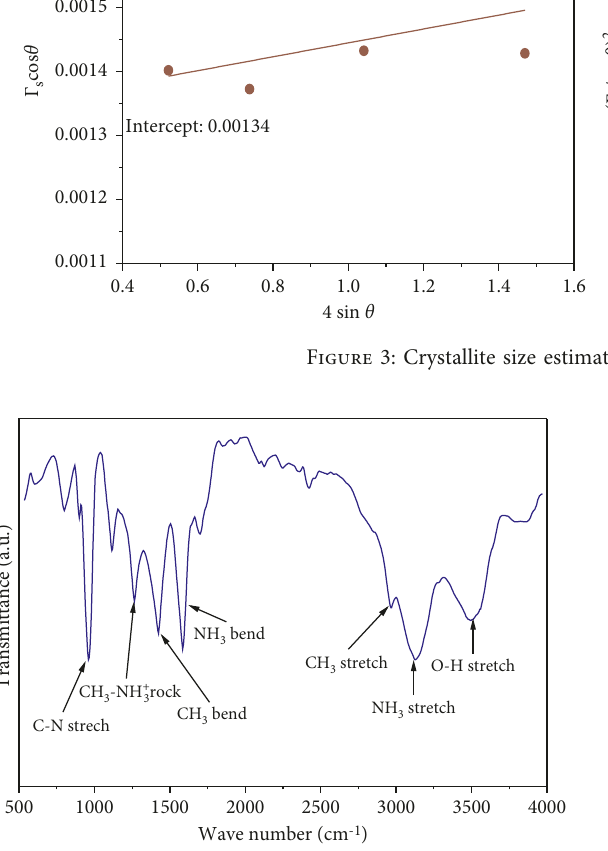
Figure 4: FTIR spectra of the MAPB perovskite.